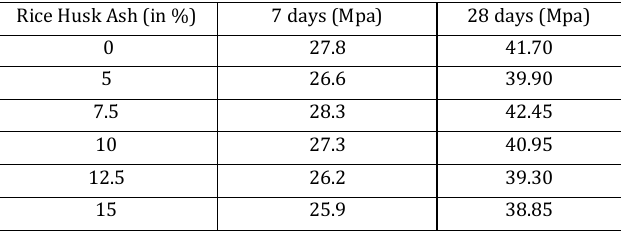
Table 5: Compressive strength of M-40 mix